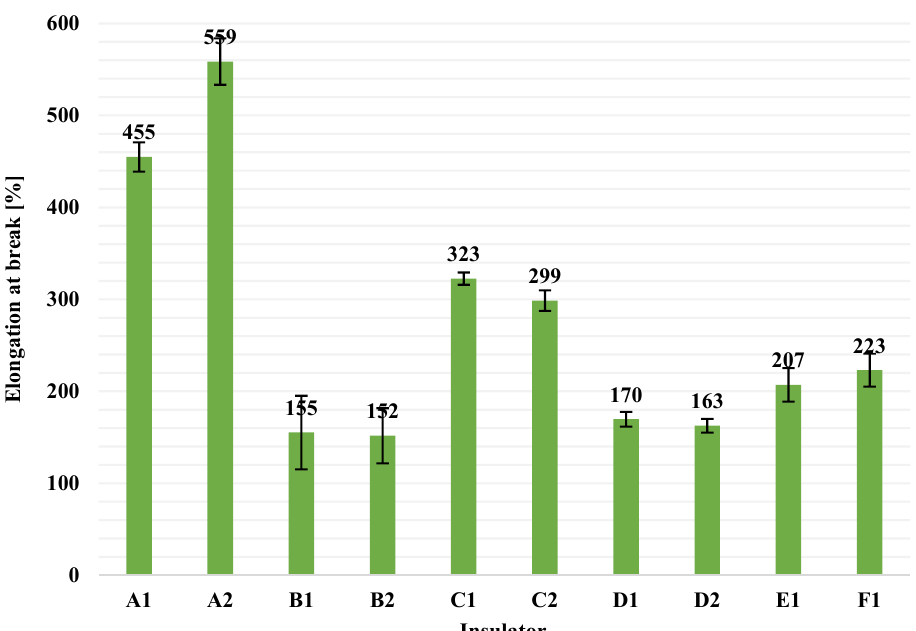
Figure 8. Average values (columns) of elongation at break (or maximum elongation, or ultimate elongation) and the corresponding standard deviations (error bars) for the HTV silicone rubber with ATH filler material of all available composite insulators.